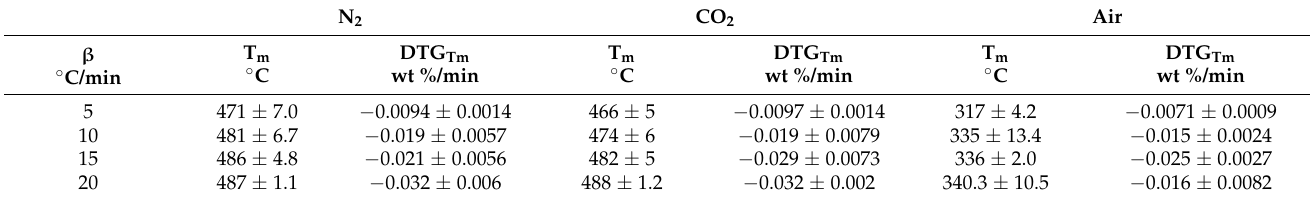
Table 5. Thermal decomposition of Subcoal™ PAF parameters in different